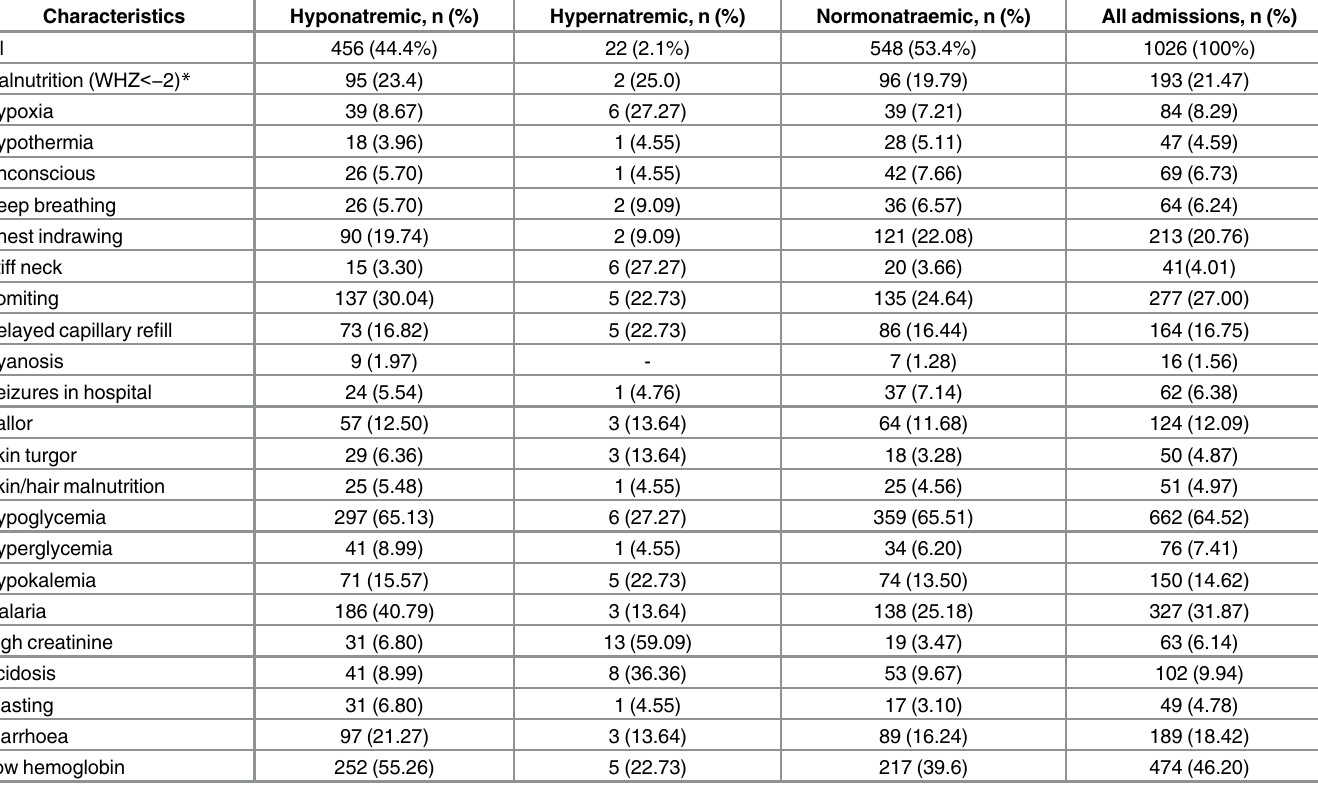
Table 2. Characteristics of study